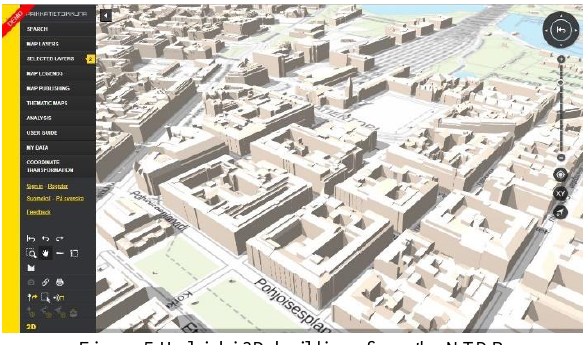
Figure 5 Helsinki 3D buildings from the NTDB Some of the Tampere city buildings had also property information and those buildings are visualized with red color.